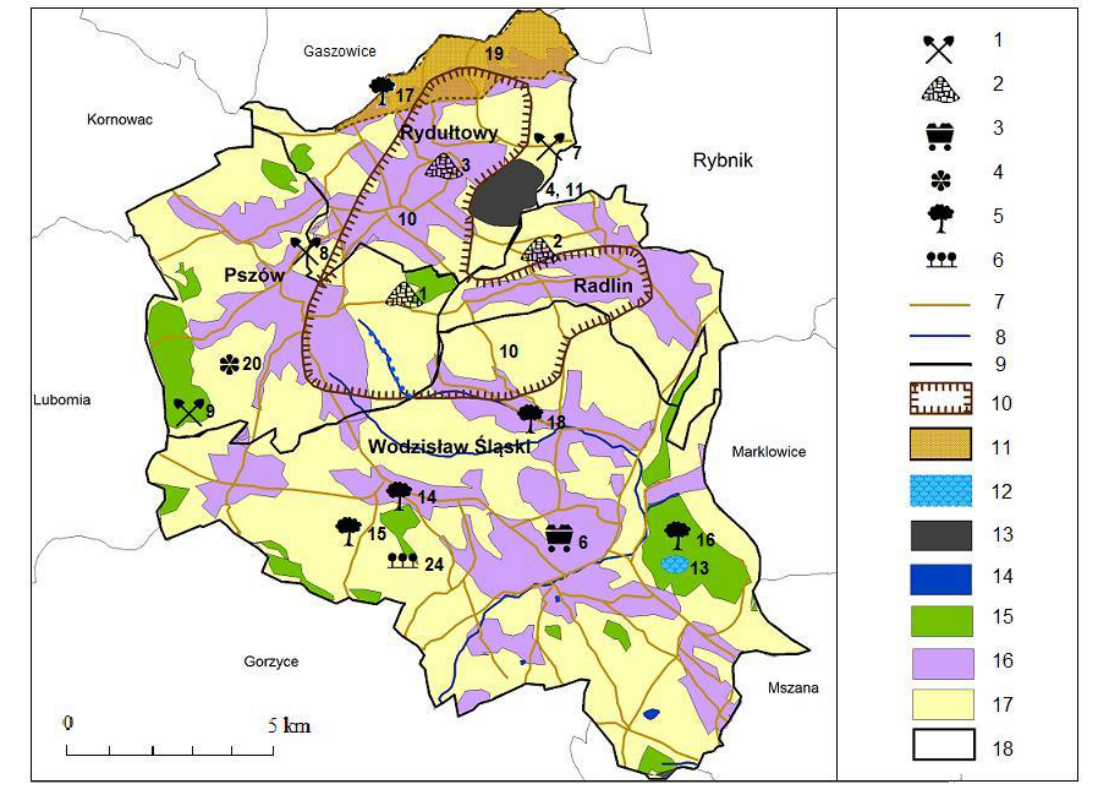
Fig. 2. Localization of nature values according to types in the studied